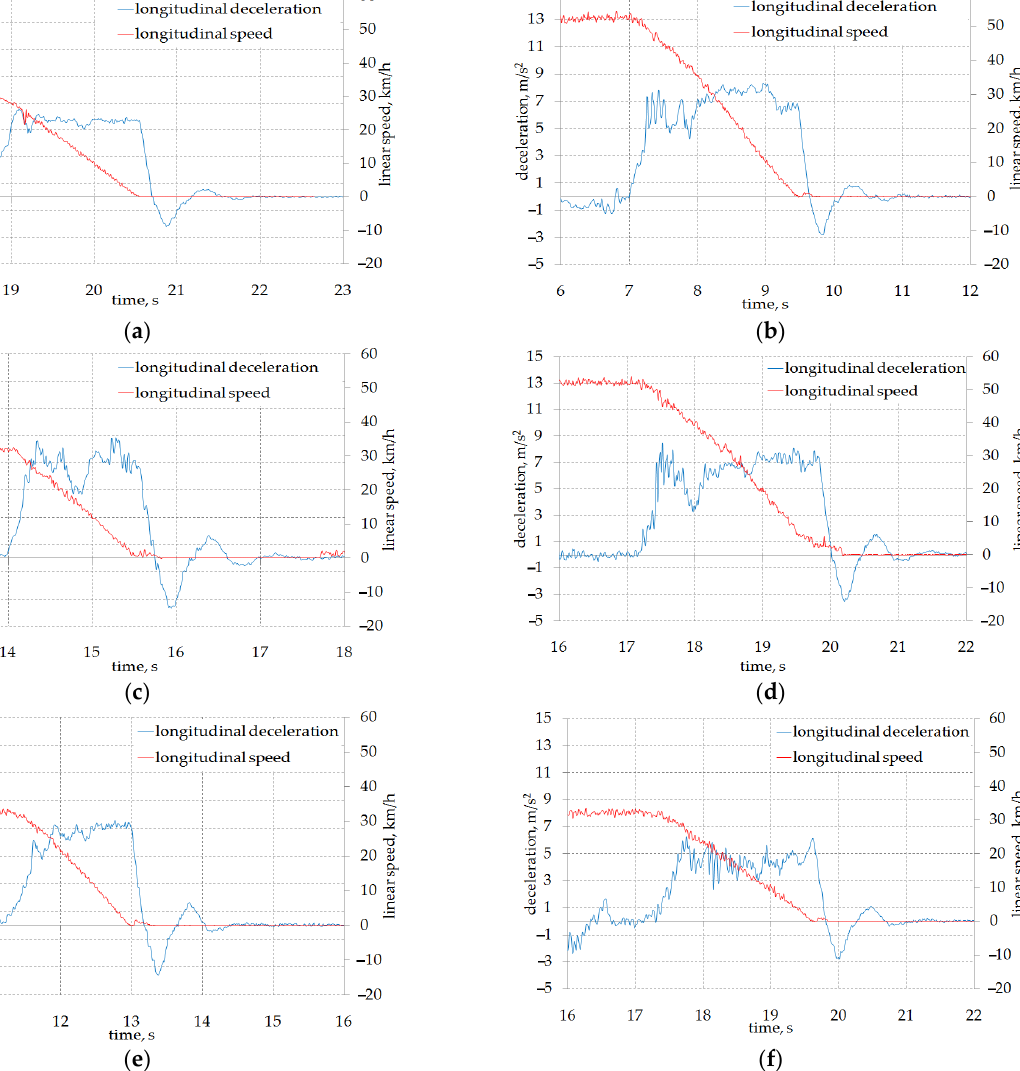
Figure 5. Examples of the presentation of values of longitudinal deceleration and longitudinal speed over time registered for a category N3 vehicle during braking tests carried out on: ( a ) dry asphalt pavement from 30 km/h, ( b ) dry asphalt pavement from 50 km/h, ( c ) wet asphalt pavement from 30 km/h, ( d ) wet asphalt pavement from 50 km/h, ( e ) dry concrete pavement from 30 km/h, ( f ) wet concrete pavement from 30 km/h.